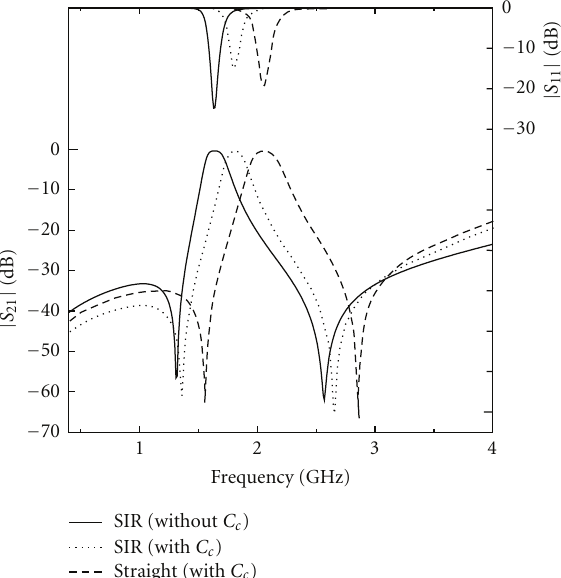
Figure 10: Coupling coe ffi cients as a function of a ( d = 0 mm).